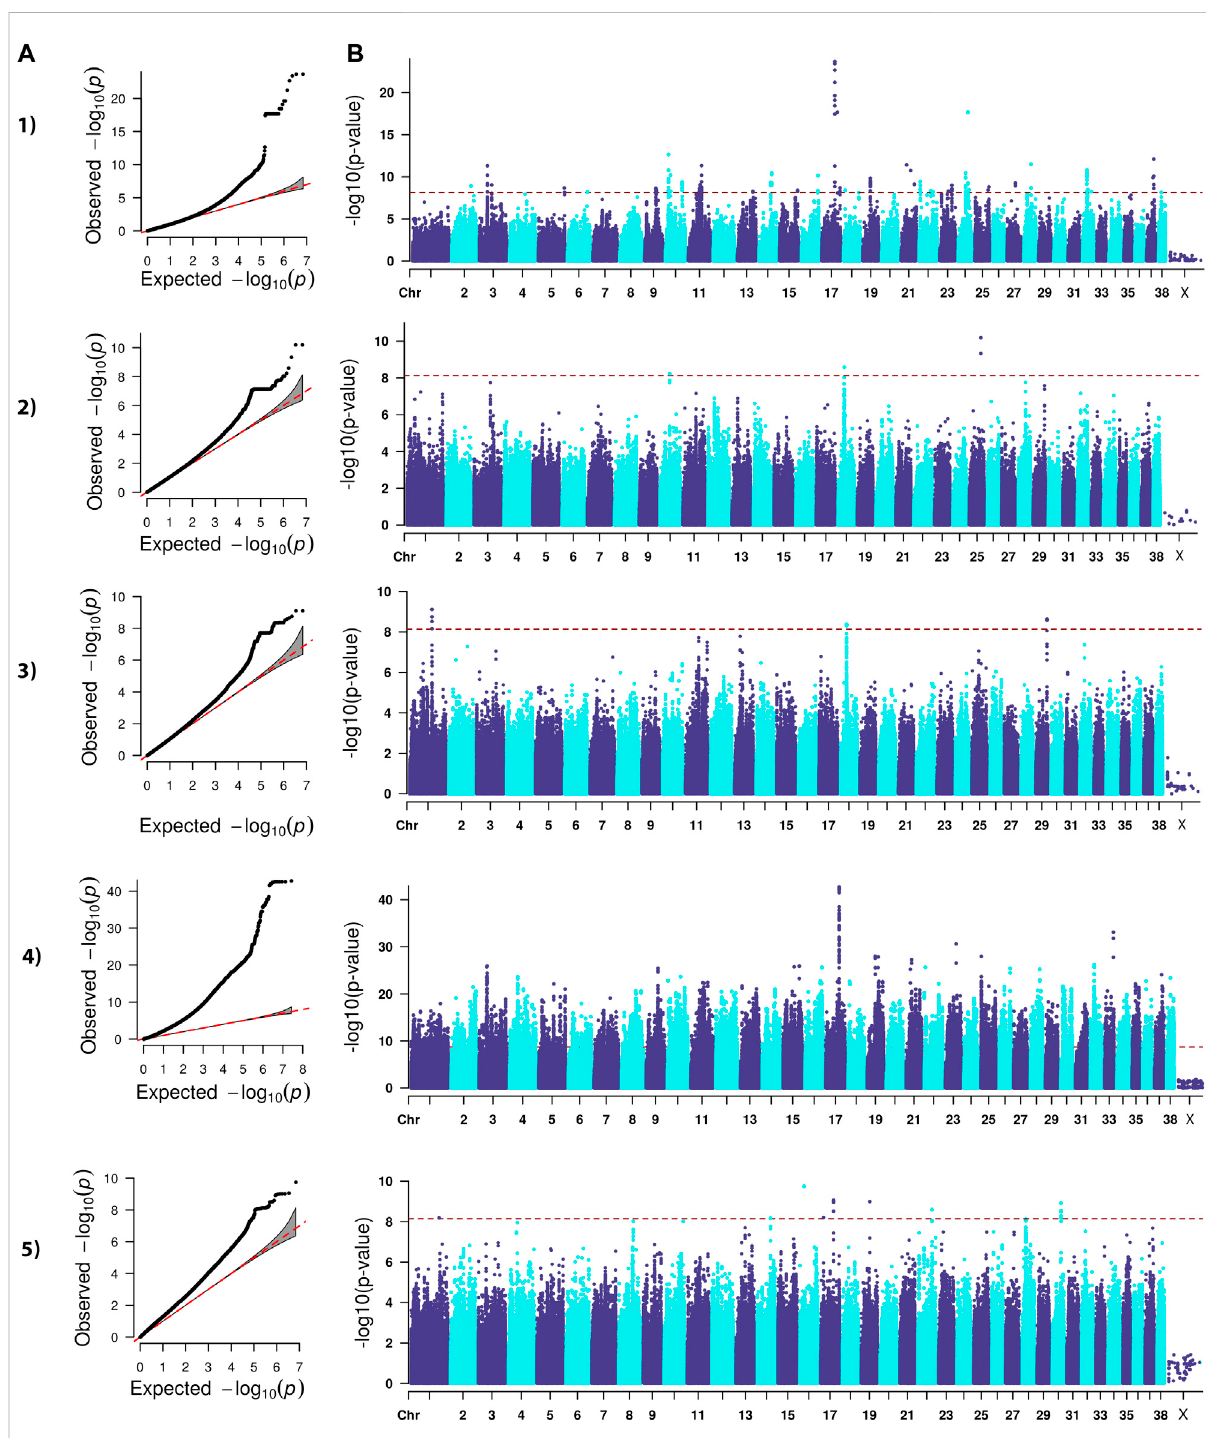
FIGURE 4 QQ (A) and Manhattan (B) plots. Comparison of four models for performing across-breed genome-wide association study using breed phenotypes anterior cruciate ligament rupture. 1) Linear mixed model, λ = 0.96, 219 signi fi cant single-nucleotide polymorphisms (SNPs) with the strongest associations on chromosomes 3, 10, 11, 14, 16, 17, 19, 21, 24, 28, 32, and 37 ( p < 7.12E-9). 2) Stringent binary case-control model, λ = 1.05, 5 signi fi cant SNPs on chromosomes 10, 18, and 25 ( p < 7.26E-9). 3) Lenient binary case-control model, λ = 1.03, 20 signi fi cant SNPs on chromosomes 1, 18, and 29 ( p < 7.13E-9). 4) Haplotype-based model, λ = 2.30, 38,677 signi fi cant SNPs with the strongest associations on chromosomes 3, 9, 15, 16, 17, 19, 21, 22, 23, 25, 32, and 33 ( p < 1.82E-9). 5) Weighted least squares model, λ = 1.58, 20 signi fi cant SNPs on chromosomes 1, 14, 16, 17, 19, 22, and 30 ( p <